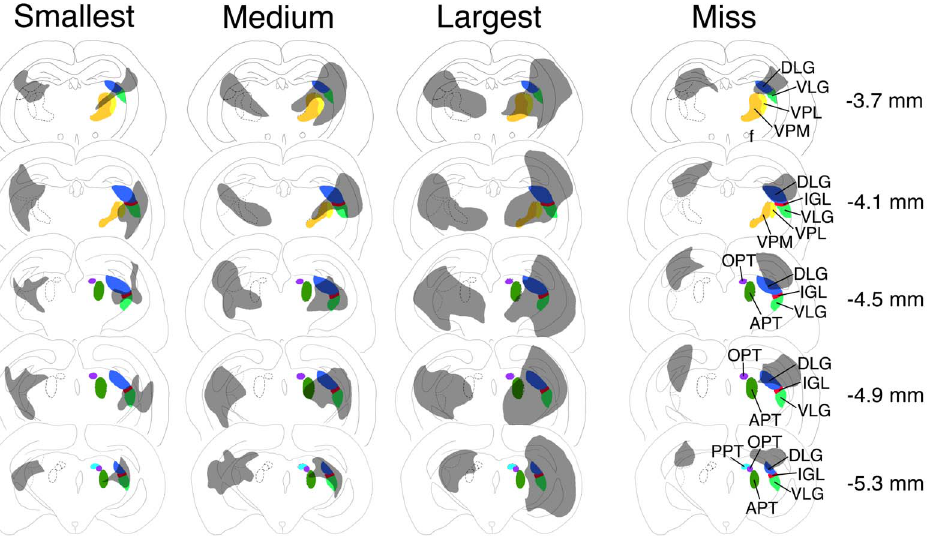
Figure 2. Smallest, medium-sized, and largest electrolytic lesions that destroyed the intergeniculate leaflet bilaterally, along with an animal that had lesions that left the IGL intact (i.e., ‘‘miss’’), seen in five coronal sections. Millimeters caudal to bregma are indicated on the right. Behavioral data for the smallest IGL lesions and miss are in Figure 3 (labeled IGL Lesion # 1 and DLG lesion, respectively). Abbreviations: DLG: dorsolateral geniculate nucleus; IGL: intergeniculate leaflet; VPL: ventral posterolateral nucleus; VPM: ventral posteromedial nucleus; OPT: olivary pretectal nucleus; APT: anterior pretectal nucleus; PPT: posterior pretectal nucleus.